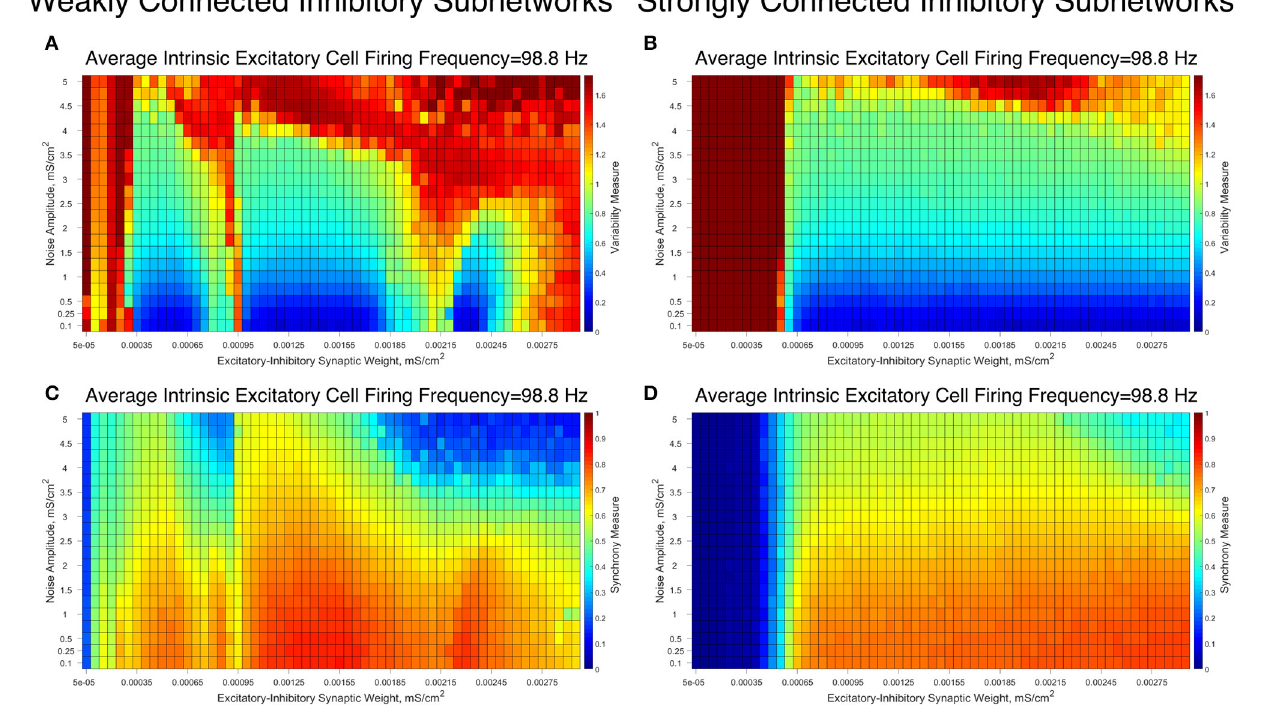
FIGURE 8 | Differences in dynamical patterns between Weak and Strong Networks are preserved in the presence of noisy drive to the excitatory cells. (A–D) Variability Measure (A,B) and Synchrony Measure (C,D) shown for Weak Networks (A,C) and Strong Networks (B,D) with an average intrinsic excitatory cell firing frequency of 98.8 Hz in the presence of noise with varying amplitudes (y-axis). E-I synaptic weight is varied along the x-axis. Distinct differences in the dynamics articulated by the Variability Measure and Synchrony Measure are still seen between Weak and Strong Networks, with the major similarity being that both networks similarly devolve into asynchronous excitatory cell firing with high-amplitude